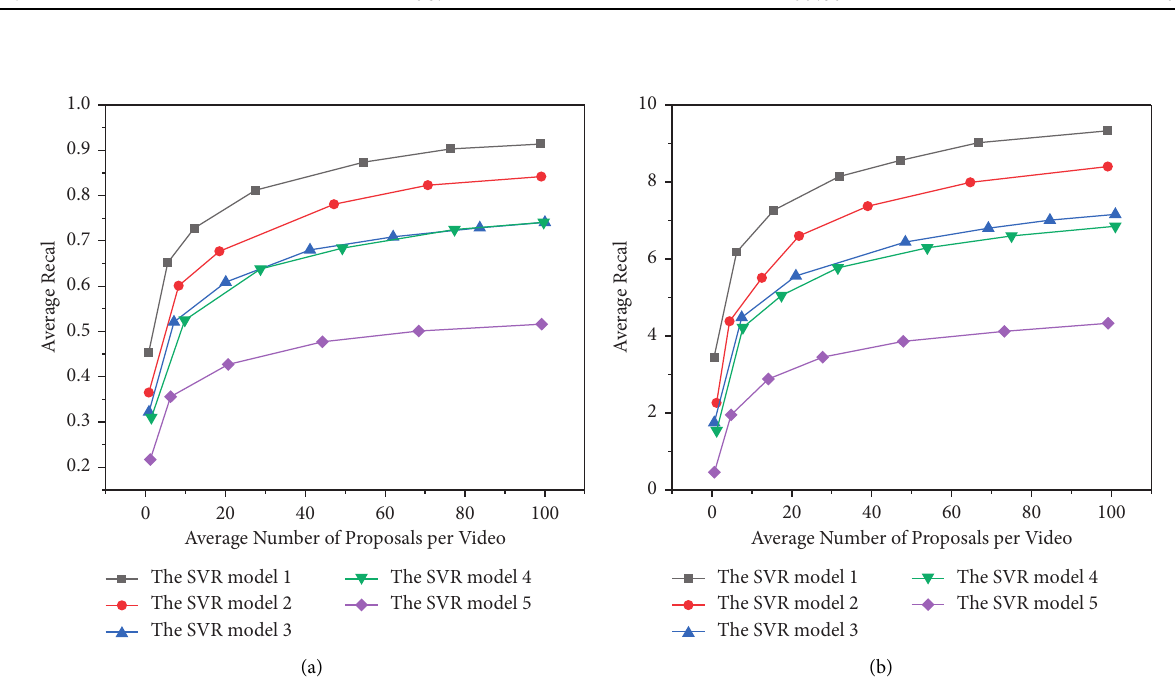
Figure 5: AR@tIoU curve before and after